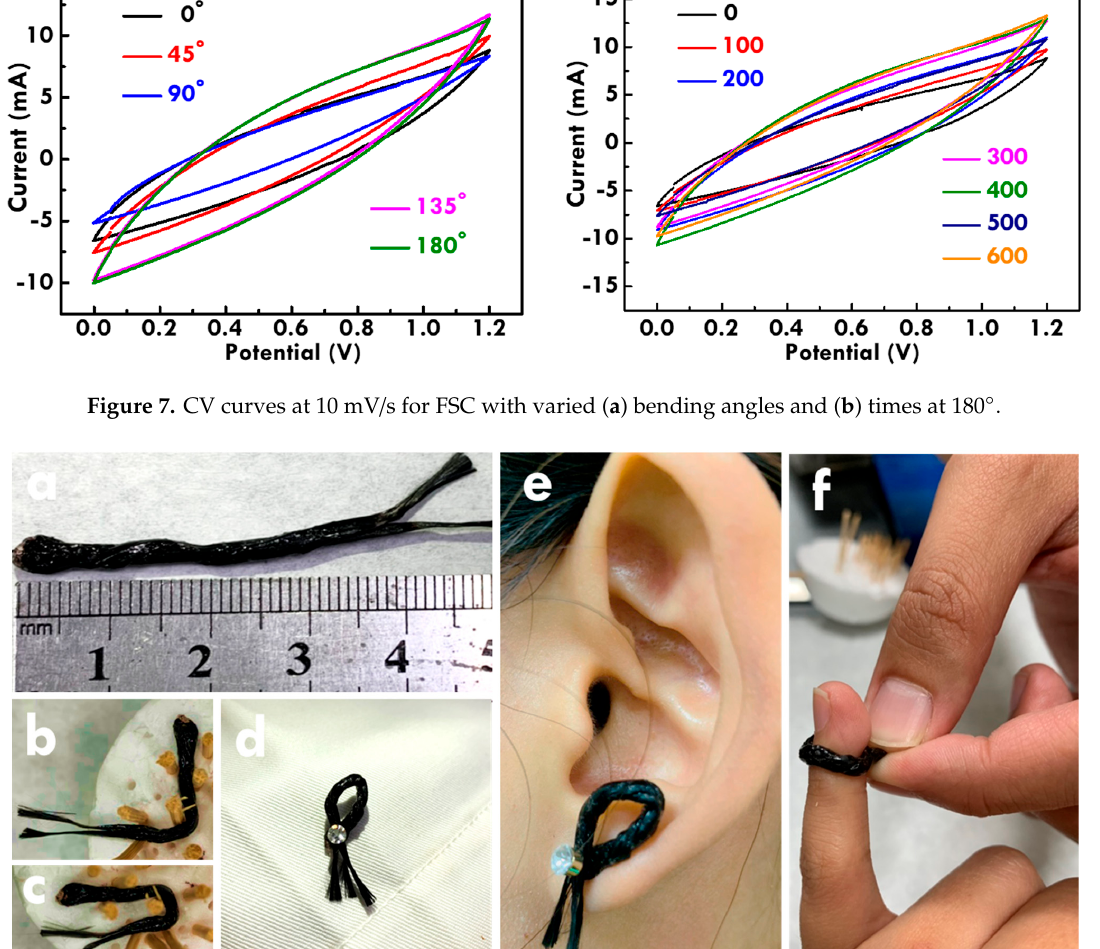
Figure 8. The photos for the FSC ( a ) without bending, ( b ) bended in 90°, ( c ) bended in 180°, bended in the circle shape and ( d ) attached in cloth, ( e ) wore as the earring, and ( f ) wore as the ring.